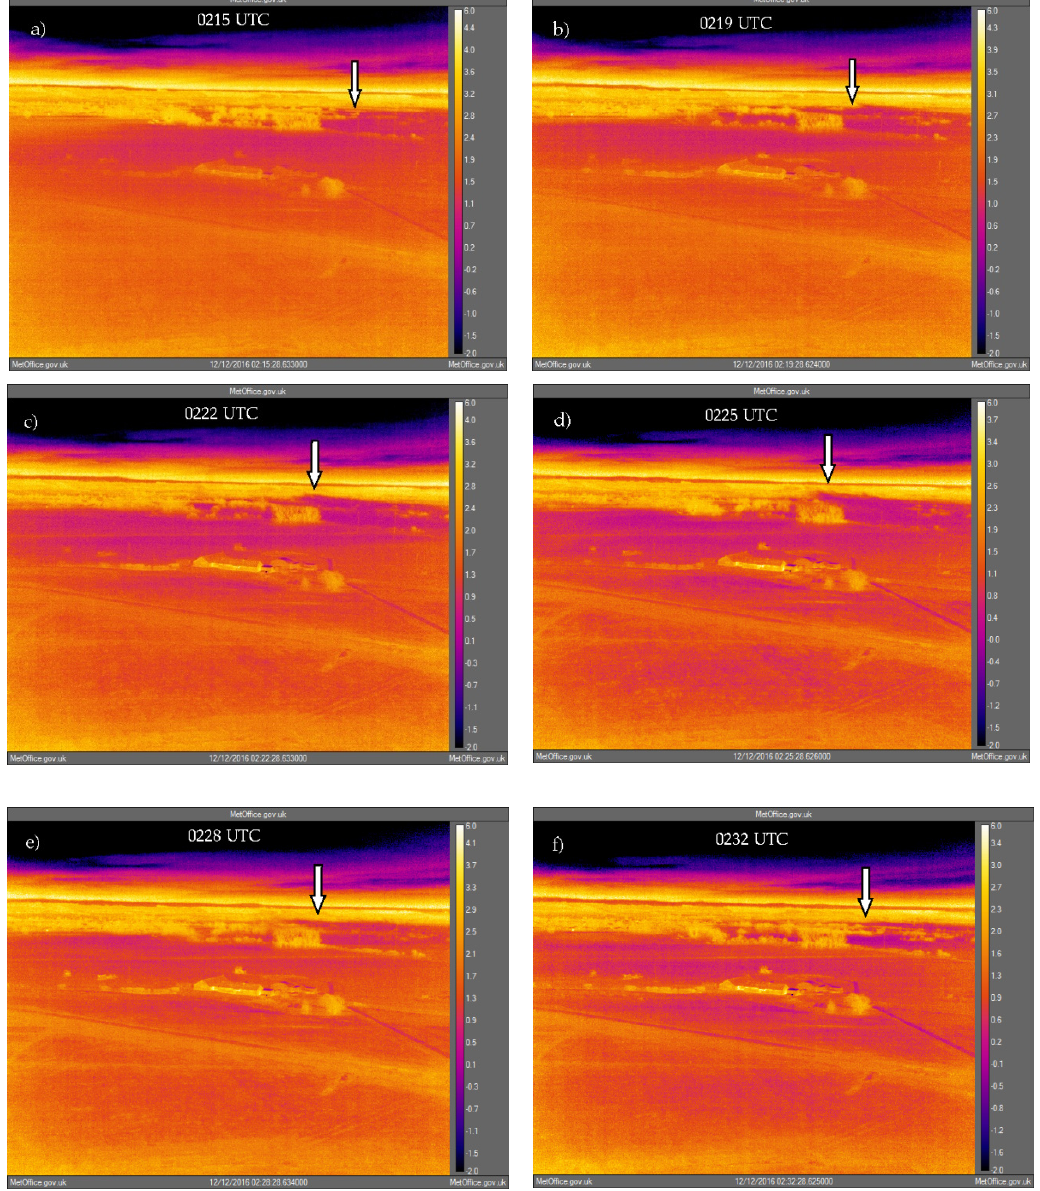
Figure 10. IR imagery for 11–12 December 2016 at ( a ) 0215 UTC, ( b ) 0219 UTC, ( c ) 0222 UTC, ( d ) 0225 UTC, ( e ) 0228 UTC and ( f ) 0232 UTC. Arrows indicate a sloshing event.